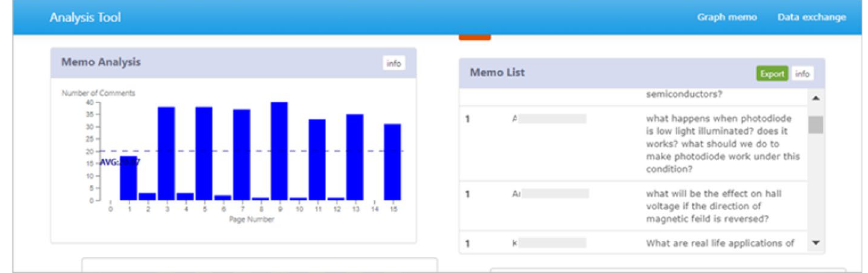
Fig. 4 A screenshot of the LAViEW Dashboard section related to